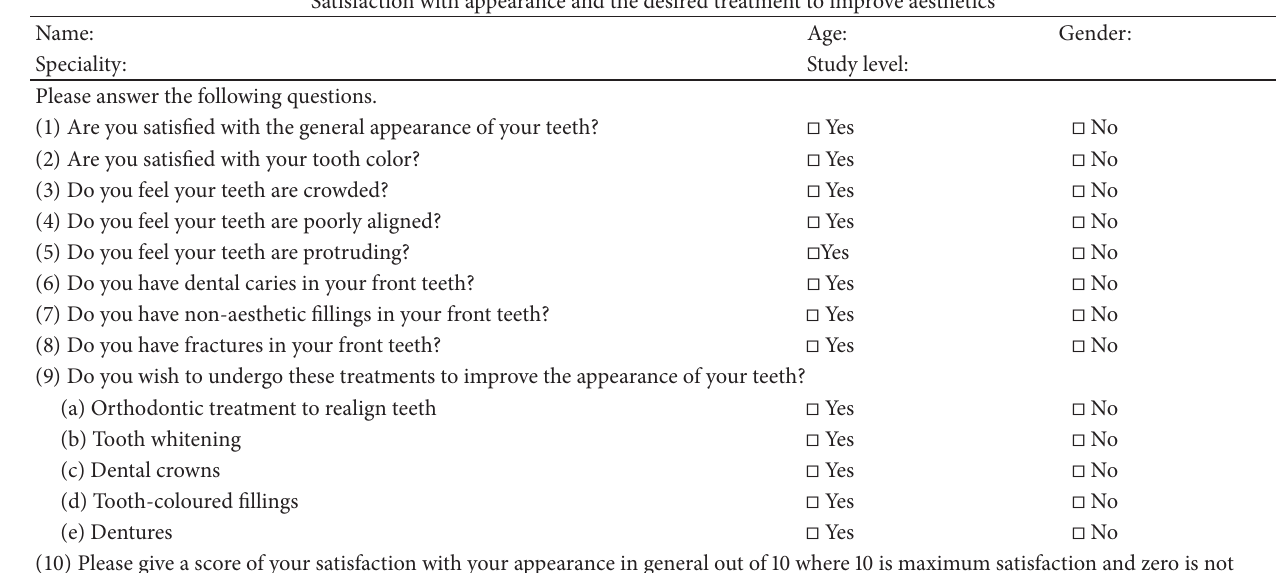
Table 1: The used questionnaire in the study.